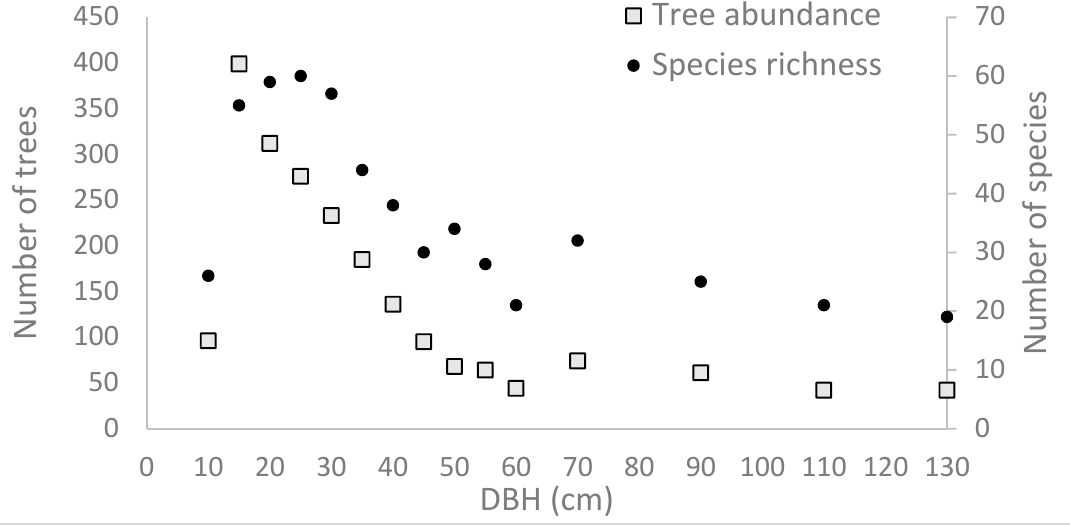
Figure 4. A unimodal distribution of the number of trees and number of species within Kumasi, Ghana.